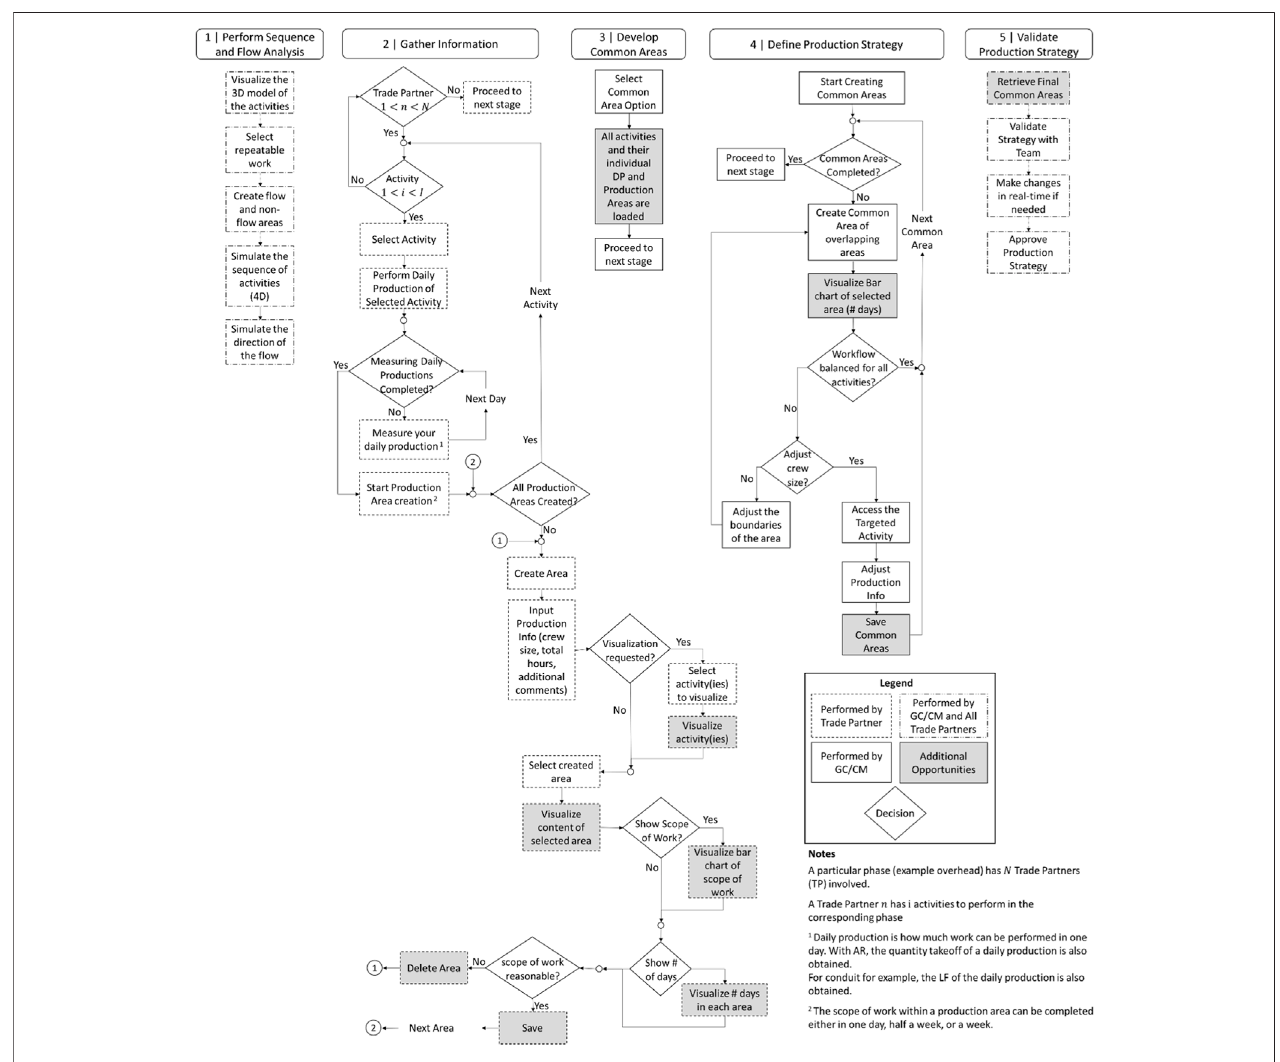
FIGURE 1 | Flowchart of the AR-enabled future state of the production strategy process.